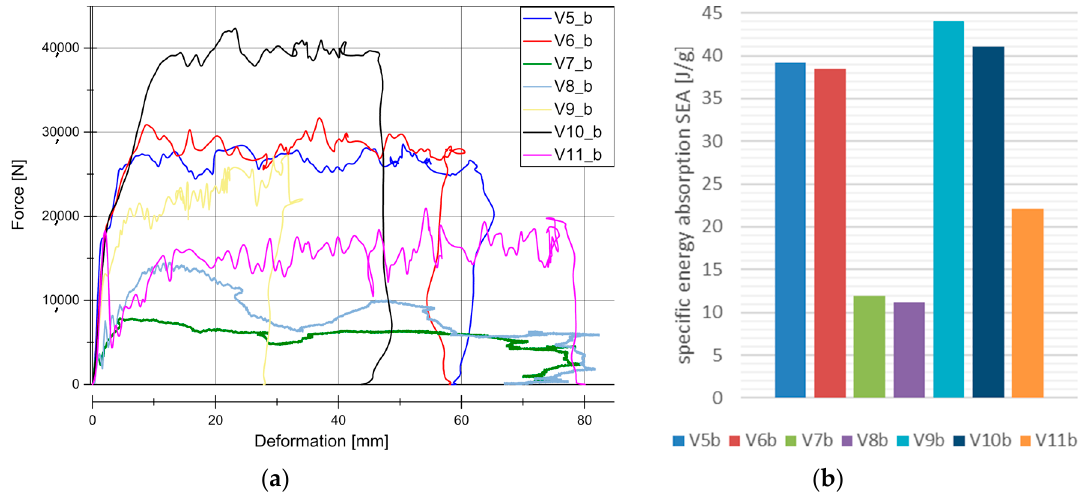
Figure 7. Results for dynamic experiments (series “b”). ( a ) Load-Deformation curve for all the materials under dynamic conditions; ( b ) SEA for all the material under dynamic conditions.